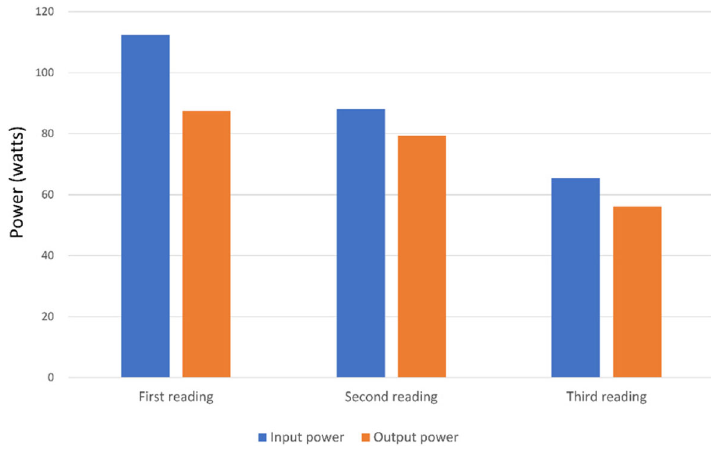
Fig. 10 Input and output power when: MPPT charge controller is connected